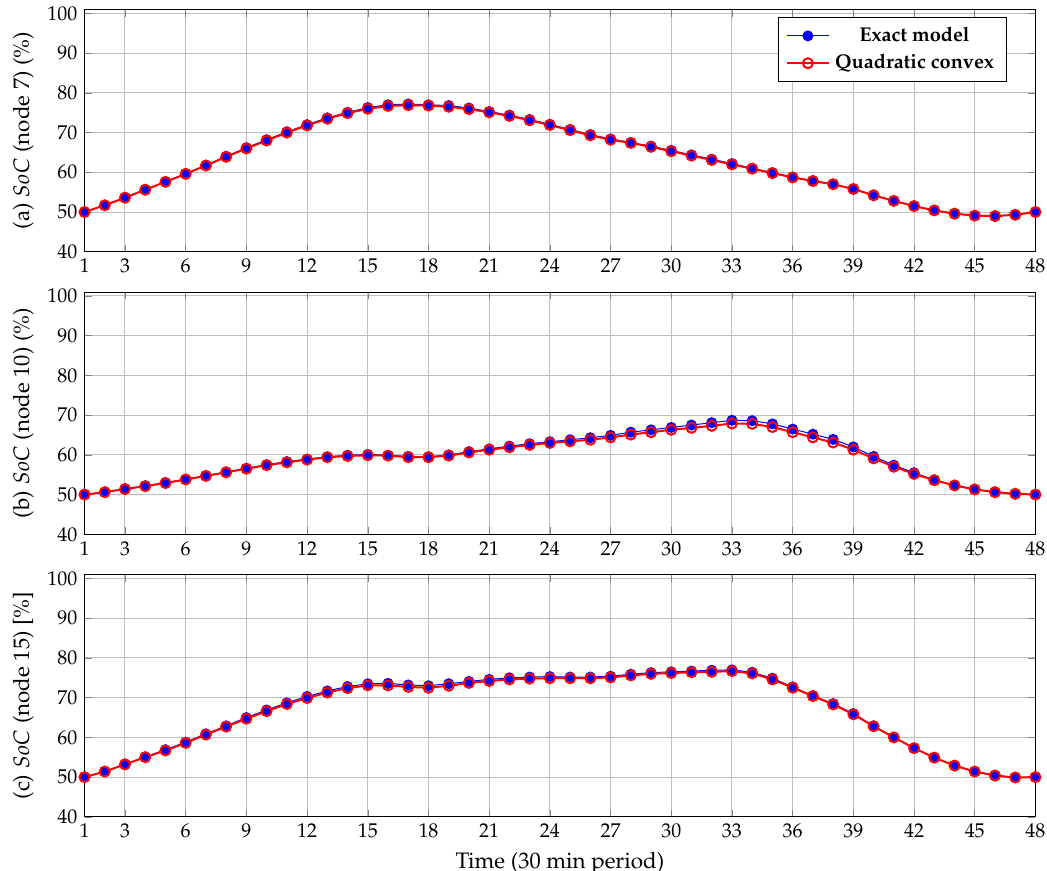
Figure 4. Profile of the state of charge in all the batteries with the exact and convex quadratic models: ( a ) SoC profile at node 7, ( b ) SoC profile at node 10, and ( c ) SoC profile at node 15.